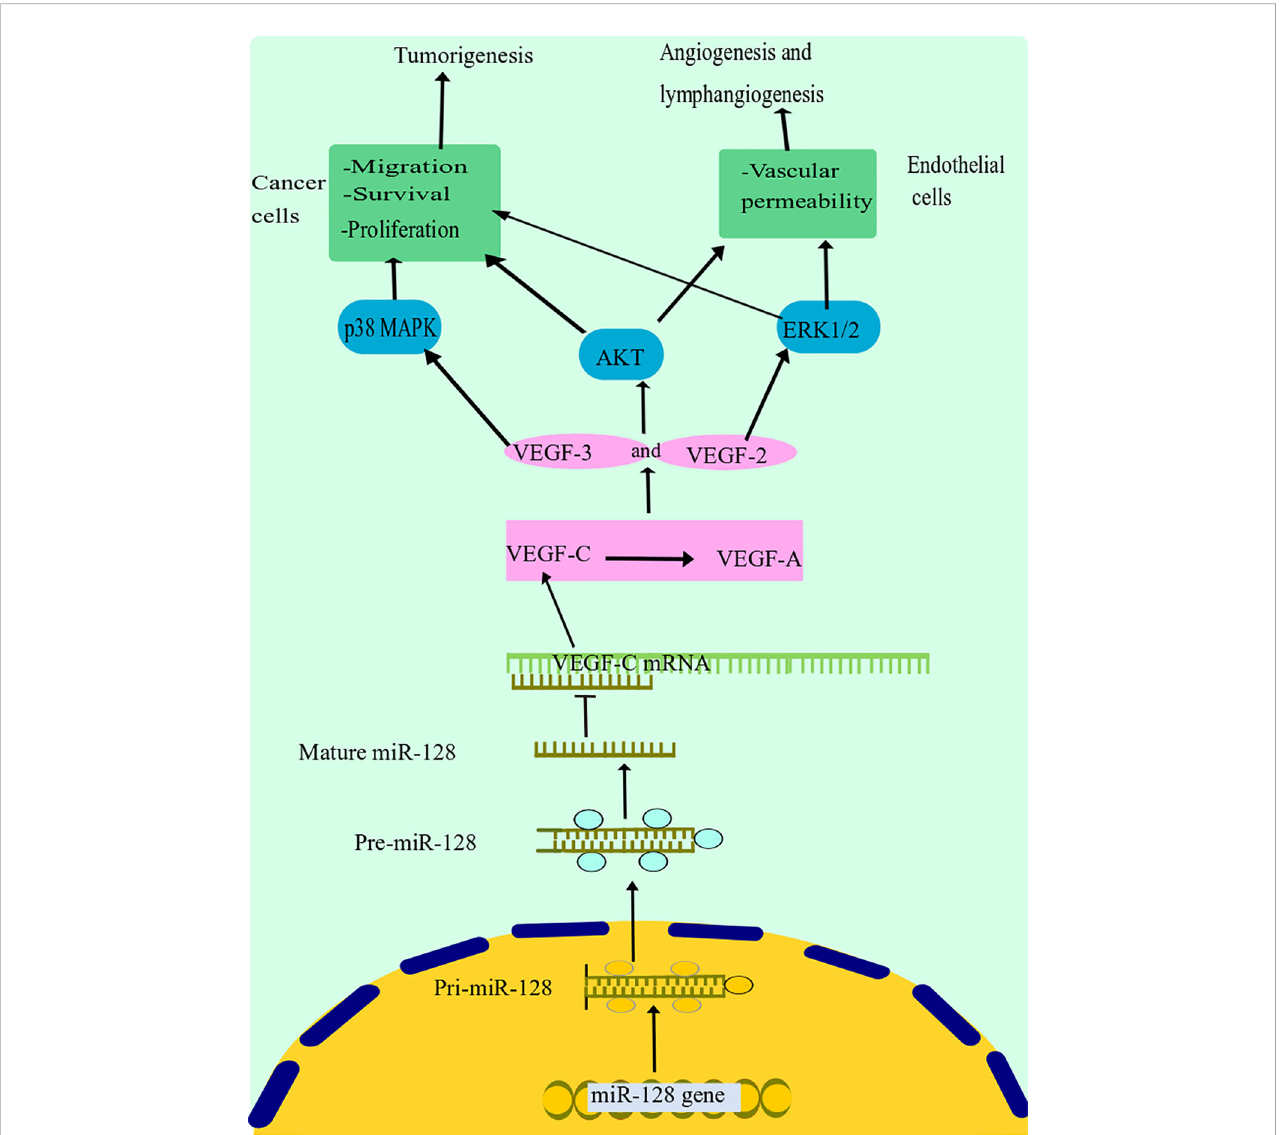
lymphangiogenesis and tumorigenesis, as well as decreased phosphorylation of the phosphatidylinositol 3-kinase and extracellular signal-regulated kinase (ERK). Additionally, it has been discovered that miR-128 may have a function in NSCLC carcinogenesis, partly through the modulation